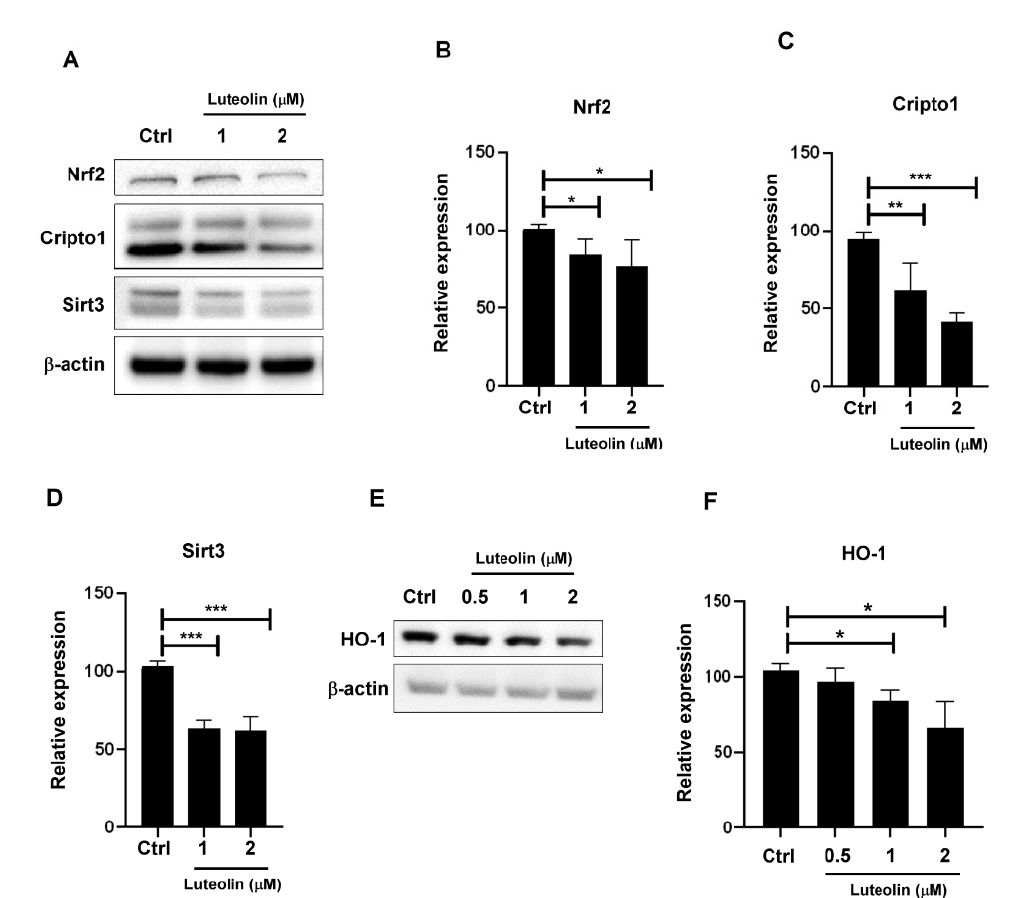
Figure 2. ( A ) Nrf2, Cripto-1, and SIRT3 expression was analyzed via Western blot after 48 h of luteolin treatment. ( B – F ) Quan- tification of Nrf2, Cripto-1, Sirt3, and HO-1 expression. Data are shown as the means ± standard errors of the mean of at least three independent experiments. Two-tailed Student’s t -test: * p < 0.05, ** p < 0.01, *** p <